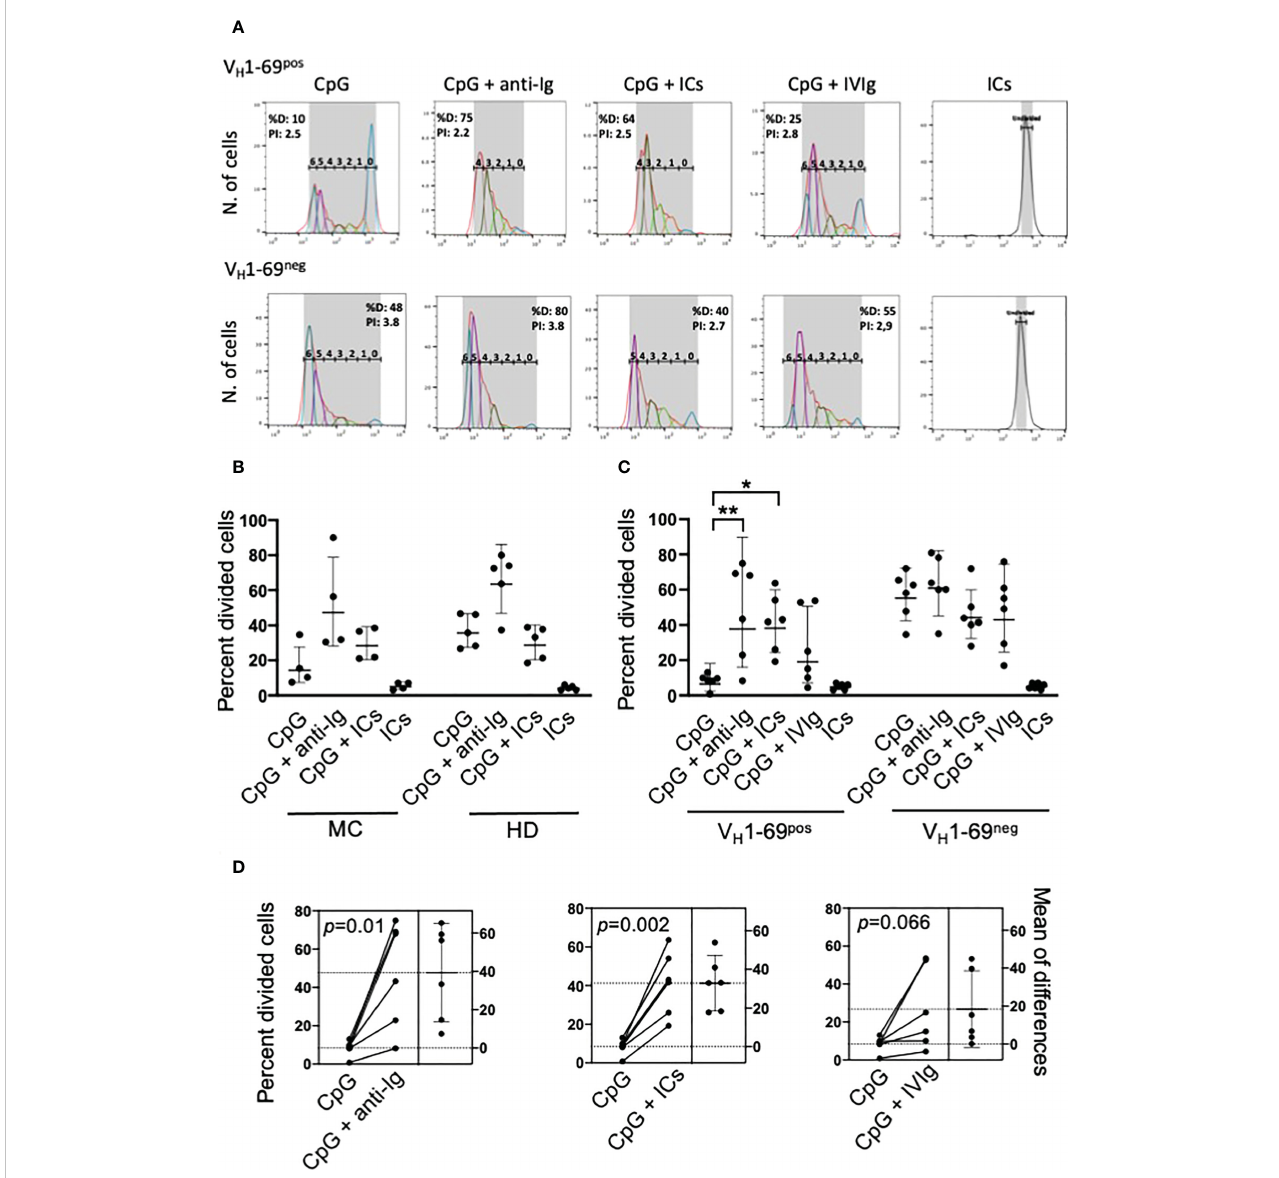
FIGURE 1 Co-stimulation with autoantigen (ICs) and CpG drives the proliferation of unresponsive RF-speci fi c B cells from MC patients. (A) Representative analysis of the proliferation of electronically gated viable V H 1-69 pos and V H 1-69 neg B cells after different stimuli. The gated peaks of CFSE fl uorescence de fi ne the number of cell divisions; %D (percent divided) is the number of cells that started dividing, and PI is the proliferation index. (B) Pilot experiments showing that stimulation with ICs and CpG, but not with ICs or CpG alone, induces the proliferation (expressed as percentage of cells that entered division, precursor cohort) of B cells from MC patients and not from healthy donors (HD). (C) ICs and not monomeric IgG (IVIg) increase CpG-induced proliferation of monoclonal V H 1-69 pos and not of V H 1-69 neg B cells of MC patients; *p=0.01, **p=0.001 by nonparametric Friedman test. (D) Estimation plots of changes in the percentage of divided V H 1-69 pos B cells after different stimuli in individual patients; p-values are calculated by paired t